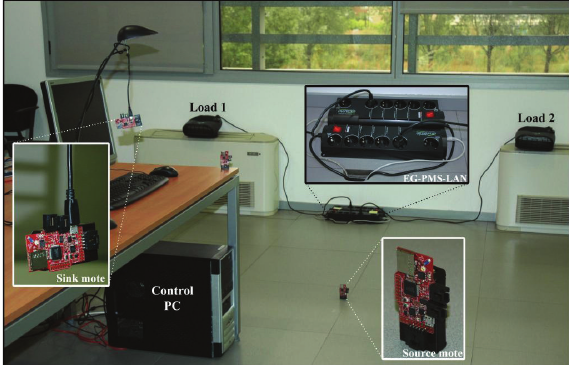
Figure 5: Z1 WSN